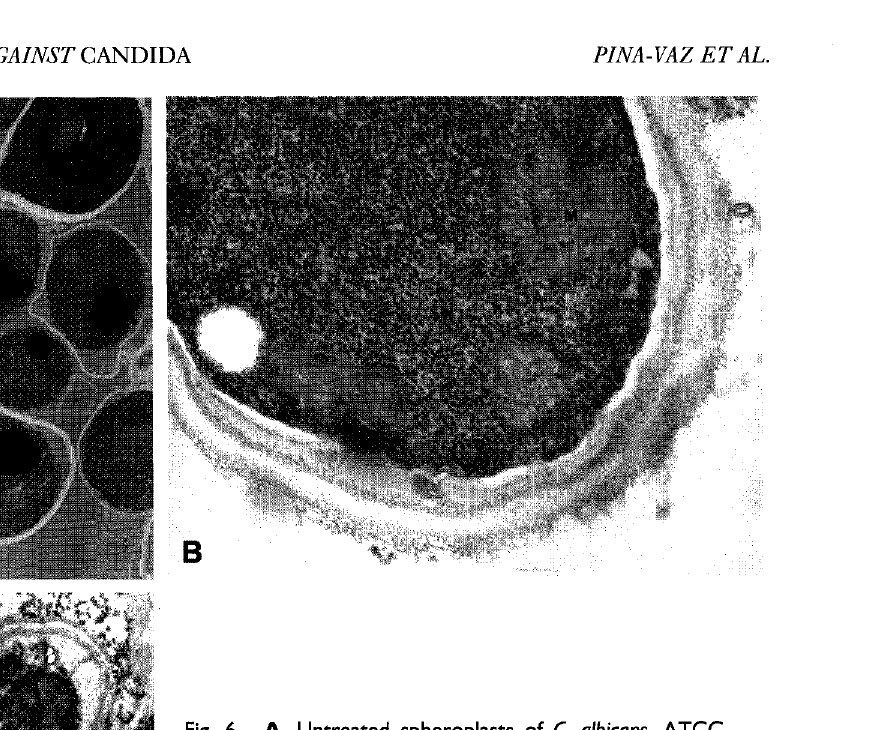
Fig. 6. /,. Untreated spheroplasts of C. albicans, ATCC strain 10231. Notice the loose partially digested cell walls (W), the intact protoplast with nucleus, mitochondria, and vacuoles. Section stained with uranyl-lead. (x 9600). B. Spheroplast from the same sample as in Fig. 6A. Section treated with 5% hydrogen peroxide for 10 minutes followed by lead staining. 2s Notice the abundant ribosomes in the cytoplasmic matrix and 3 mitochondria (M). (x 50,600). C. Spheroplasts from the same preparation as in Fig. 6A but exposed to 0.3 mg/mL of benzydamine for 15 min. Notice several lysed spheroplasts (*) with collapsed cell walls. The nonlysed spheroplasts have a very altered ultrastructure. Section stained with uranyl-lead. (x